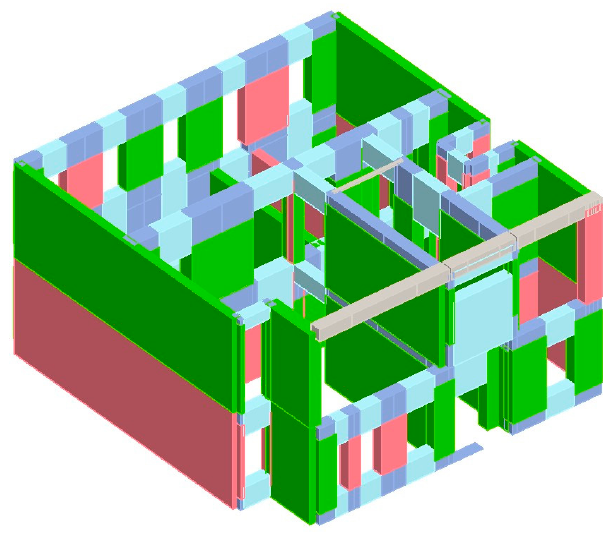
Figure 12. Damage stated due to static loads.